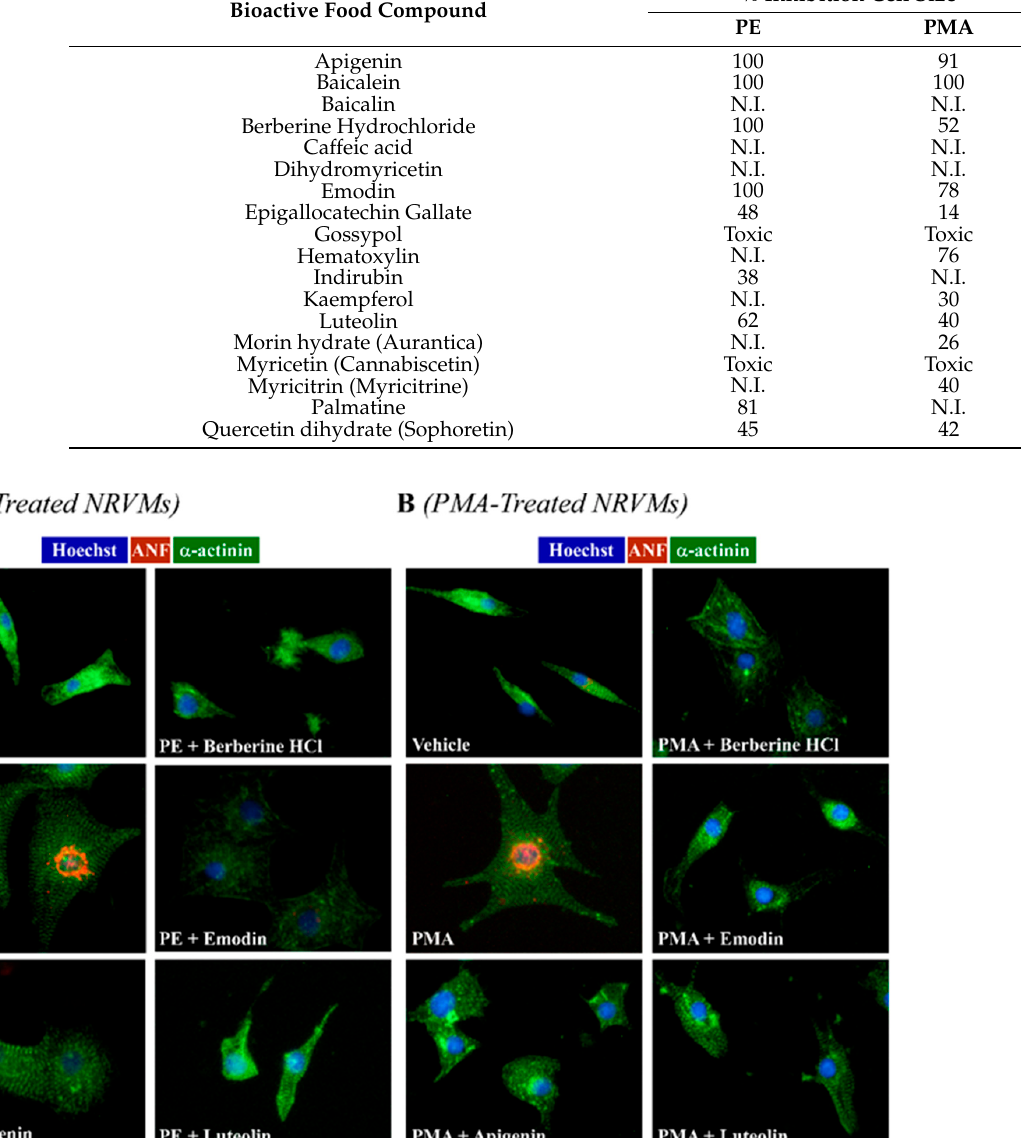
Figure 1. Select phytochemicals attenuate cardiac hypertrophy in response to PE or PMA. NRVMs were stimulated to hypertrophy with ( A ) phenylephrine (PE; 10 µM) or ( B ) phorbol 12-myristate 13-acetate (PMA; 50 nM) in the absence or presence of vehicle control or phytochemicals (Apigenin (Api), Baicalein (Bac), berberine hydrochloride (BHCL), Emodin (Emod), Luteolin (Lut), or Quercetin dehydrate (QD); All compounds were used at 10 µM). NRVMs were co-treated as indicated above and cells were fixed 48 h post-treatment and stained for α -actinin, atrial natriuretic peptide (ANP), and Hoescht. NRVMs were visualized with the EVOS FL microscope and ( C ) PE and ( D ) PMA treated cells quantified using Image J software and graphed with GraphPad Prism software. One-way ANOVA with Tukey’s post-hoc was performed and significance set at p < 0.05. *—Significantly different than all treatment groups.